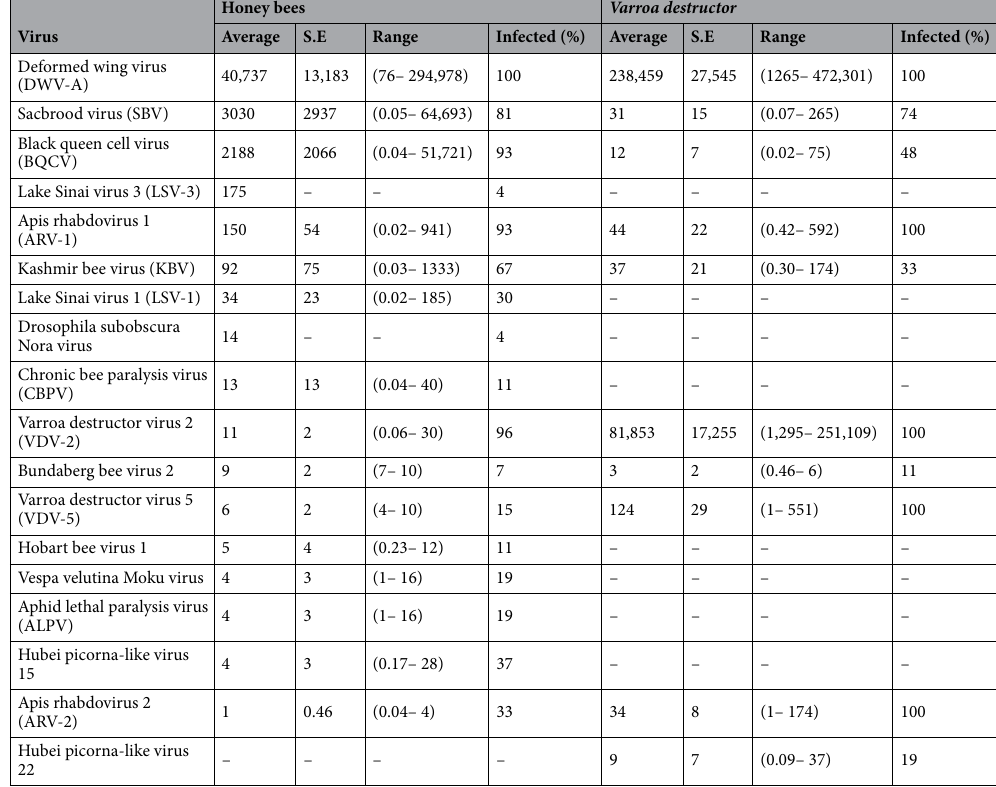
Table 1. Viruses observed in honey bees and mites from the RNA-Seq analysis. The counts are expressed as the average transcript abundance, expressed in transcripts per million (TPM). The viruses are ordered by the most to least common virus observed in honey bees. ‘S.E.’ is the standard error; ‘Infected’ is the percentage of the 27 hives from which the mite or bee samples had reads for each virus. ‘−’ indicates no virus reads were found in a sample. For the average, standard error, and range calculations we excluded the 0